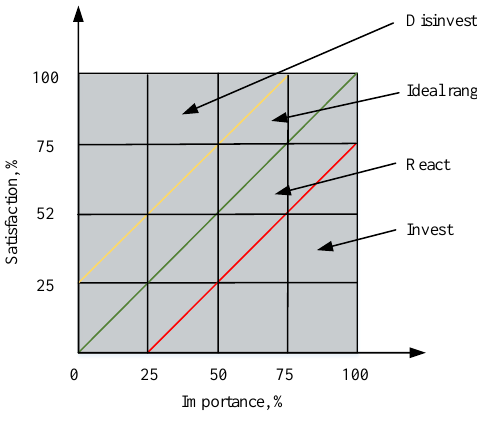
Fig. 1. Customer satisfaction matrix